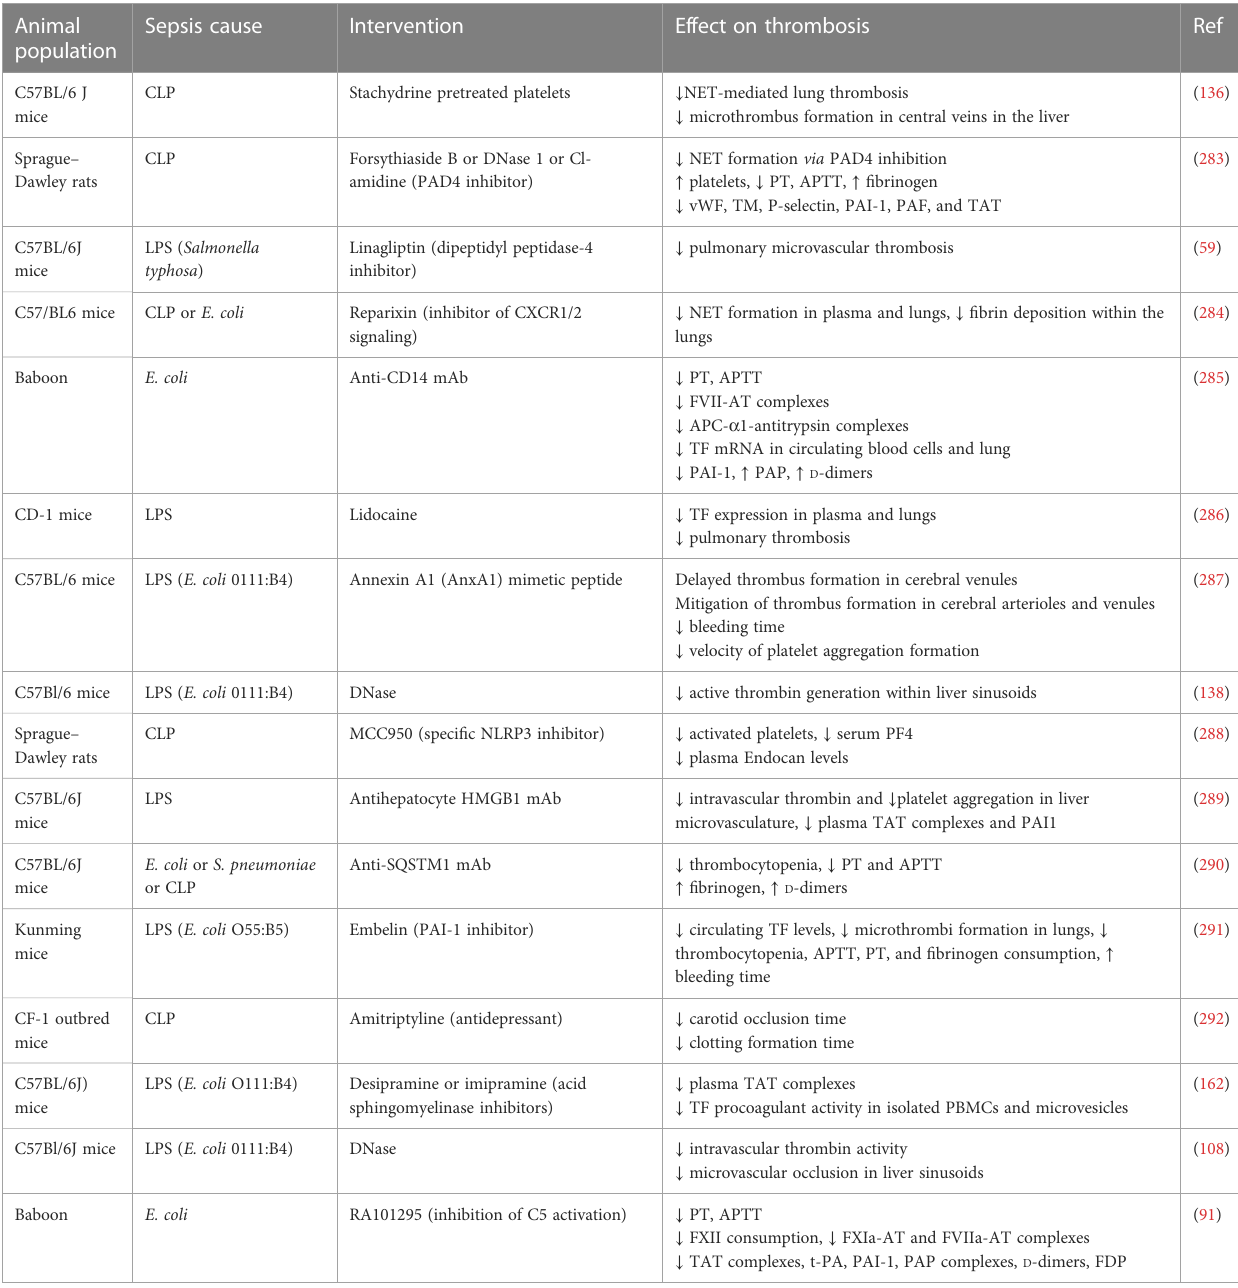
TABLE 8 Preclinical evidence of novel drugs targeting immunothrombosis in